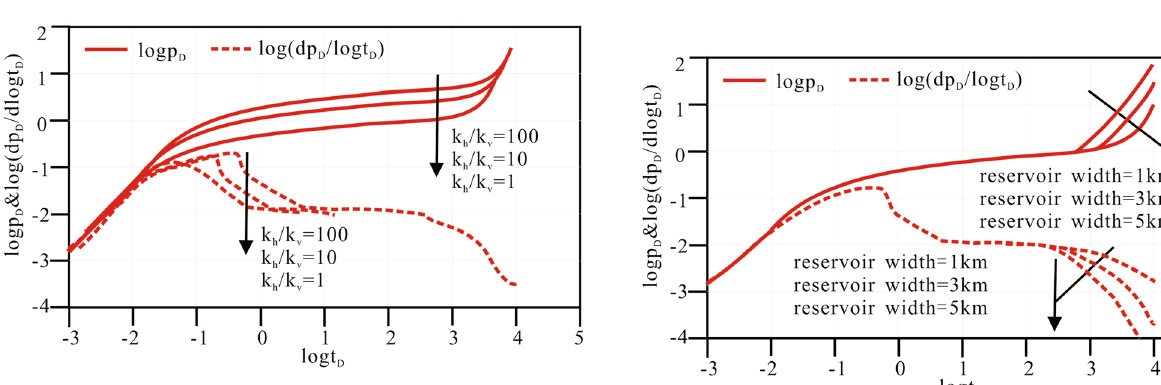
Fig. 11 The effect of reservoir boundary conditions on template curves